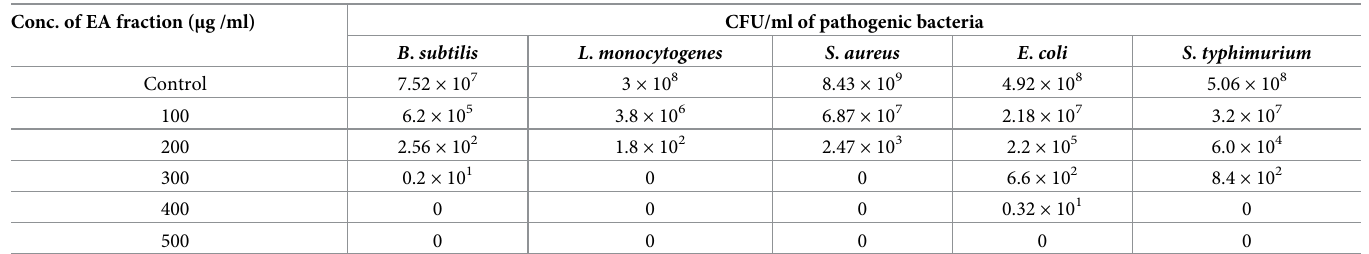
Table 2. Effect of ethyl acetate fraction of AE1 on CFUs of pathogenic bacteria. Conc. of EA fraction ( μ g /ml)